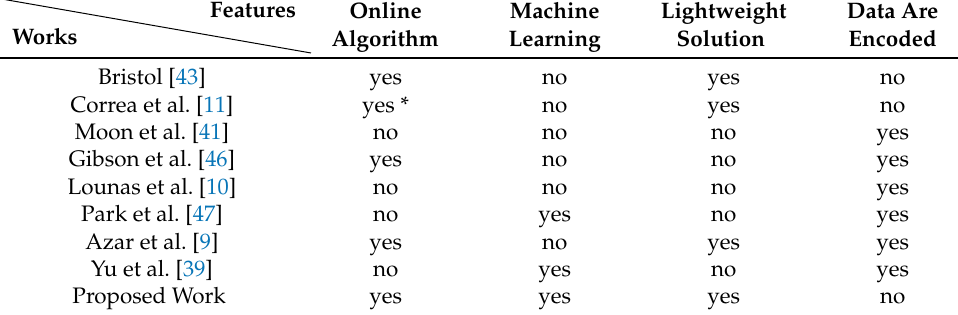
Table 1. Summary of related